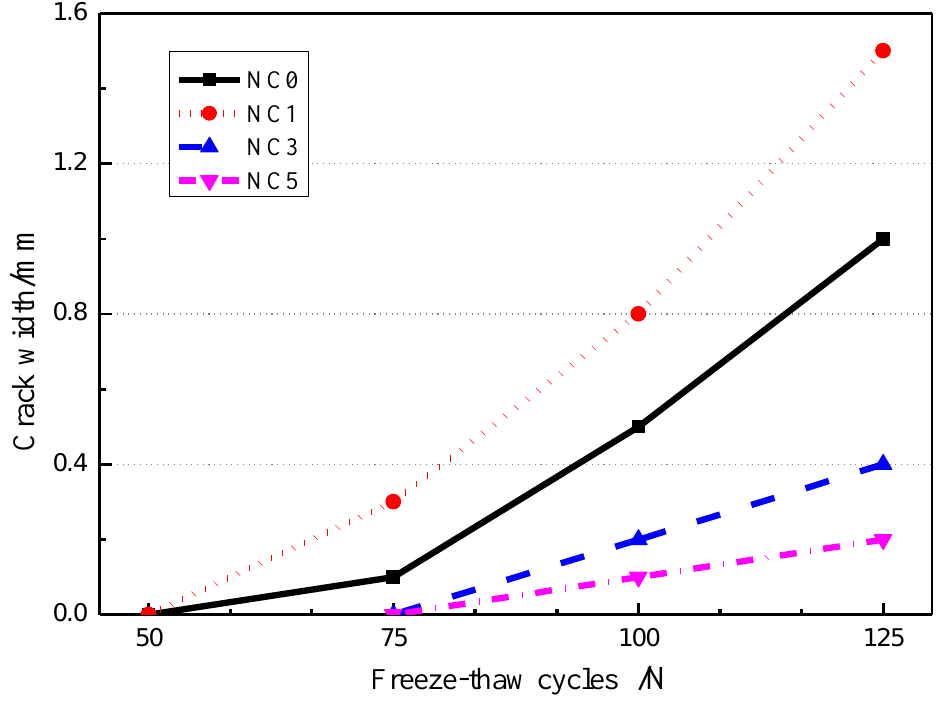
Figure 6. Widths of concrete cracks during freezing – thaw cycles.